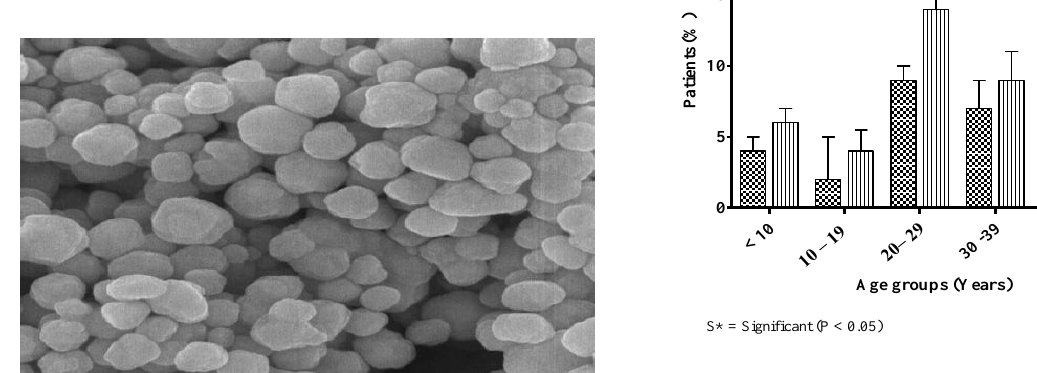
Figure 3. Distribution of the burn patients according to sex and age groups.